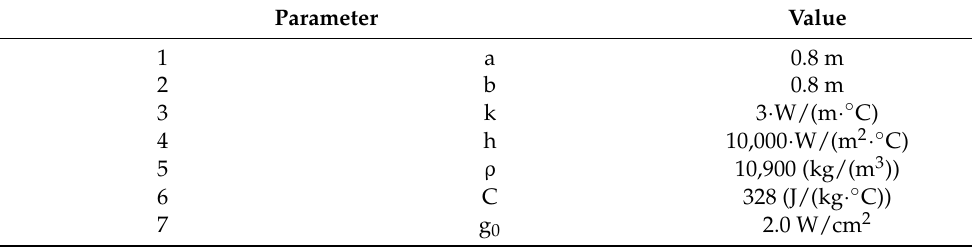
Table 5. Input parameters for the transient heat conduction